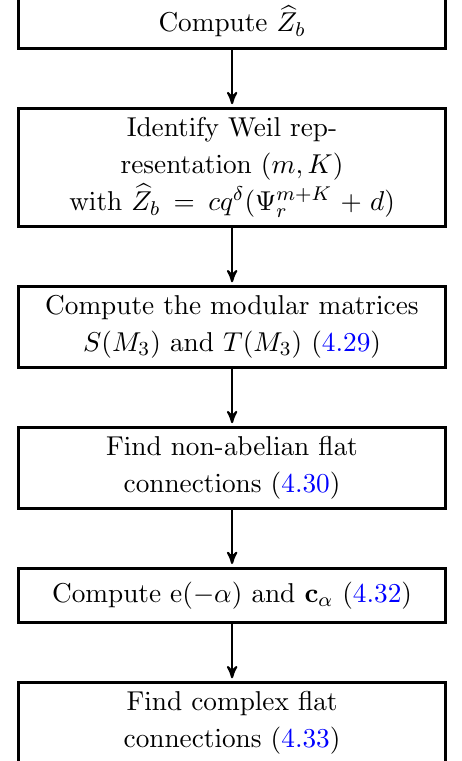
Figure 5 . From plumbing data to (cid:13)at